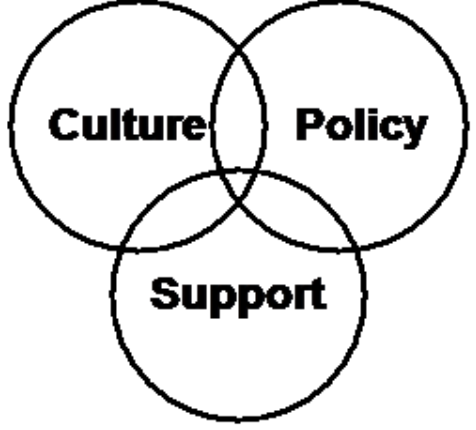
Figure 1. Simplified Model of the Factors Identified As Important in the Adoption of Changes in Teaching and Learning Practice (McNaught, Phillips, Rossiter, andWinn,